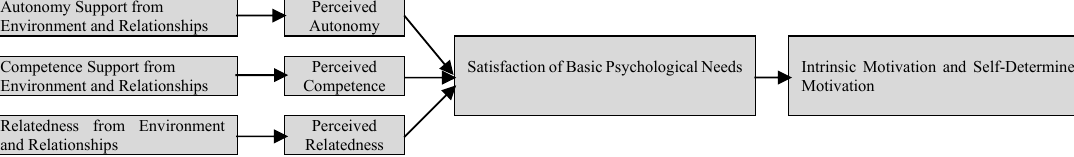
Fig. 1. The role of need satisfaction in motivation according to self-determination theory (Legault,